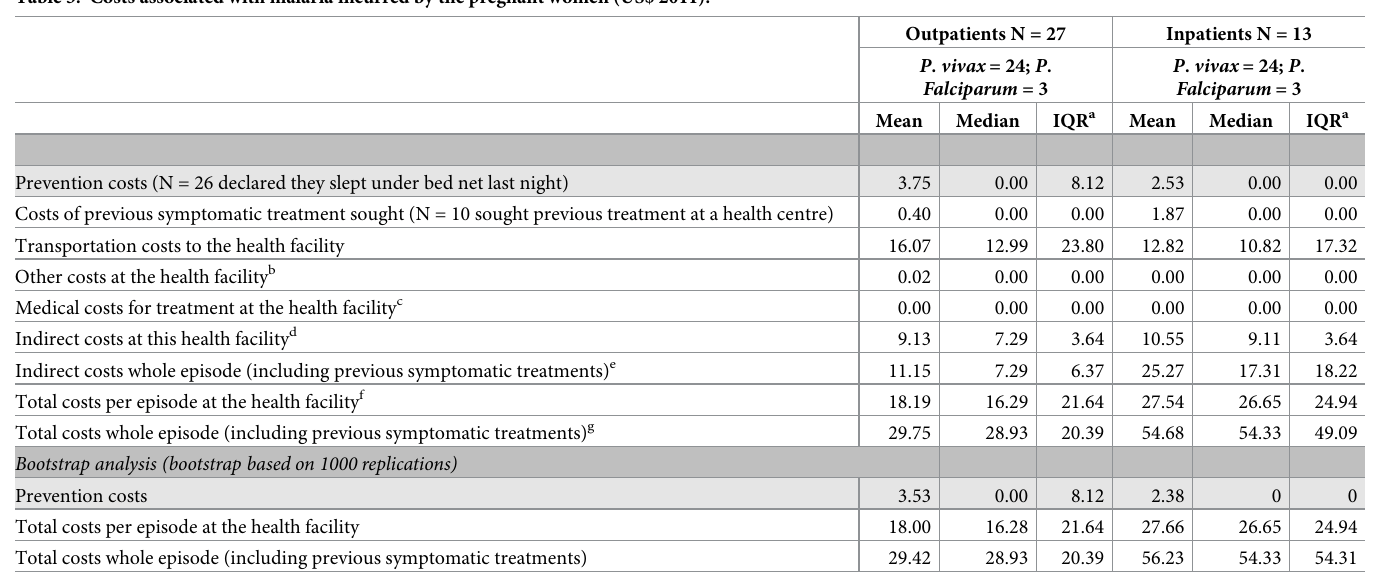
Table 3. Costs associated with malaria incurred by the pregnant women (US$